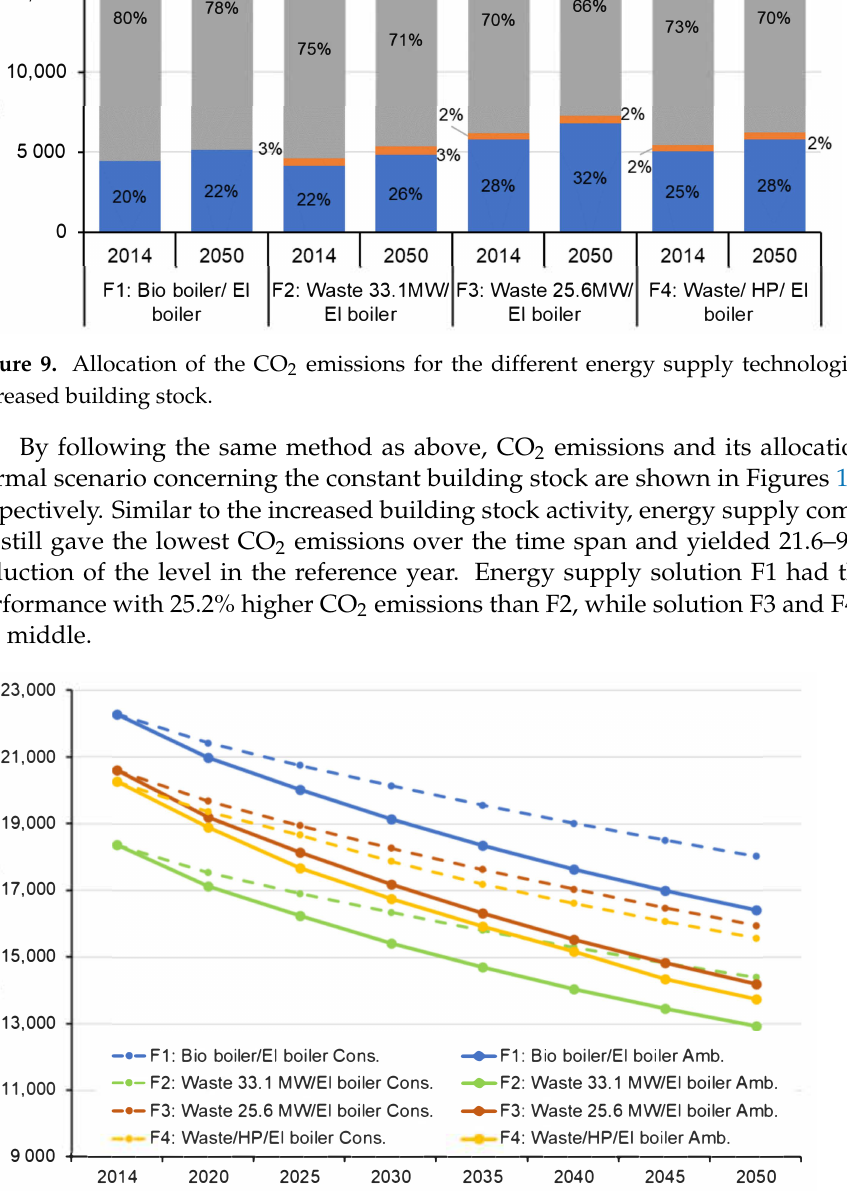
Figure 10. CO 2 emissions of the constant building stock considering different development